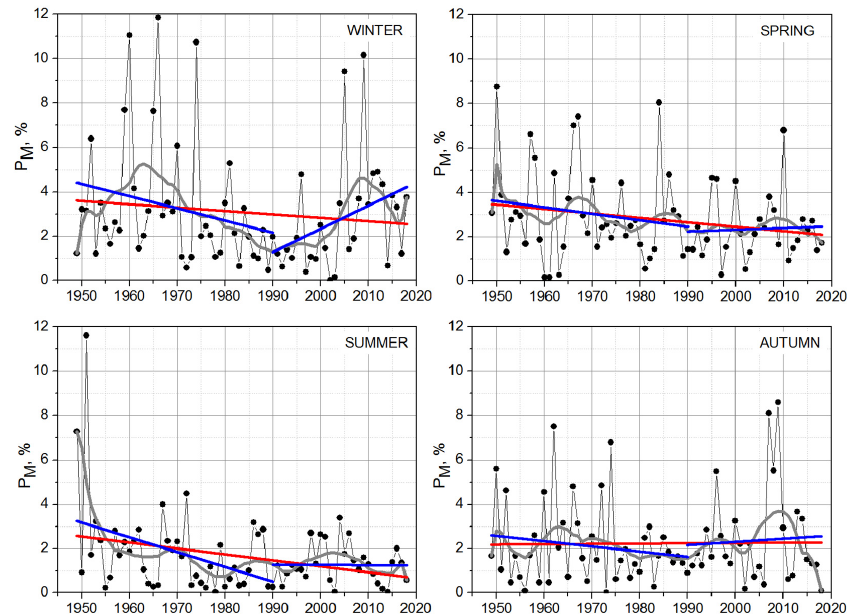
Figure 16. Variations in the average seasonal probability of transport, Pm [%], of air particles from the boundary layer over the deserted territory of Kalmykia to the Moscow region in 1949–2018. (black line). The gray line is the 10-year moving average. The red line is a linear annual trend in 1949–2018. Blue lines are linear annual trends in 1949–1989 and in 1990–2018. Table 3. Linear annual trends, k [%/(10 years)], and their significance, p , for the average seasonal probability of air particles transport from the deserted lands of Kalmykia to the Moscow region in 1949–2018, 1949–1989 and 1990–2018.